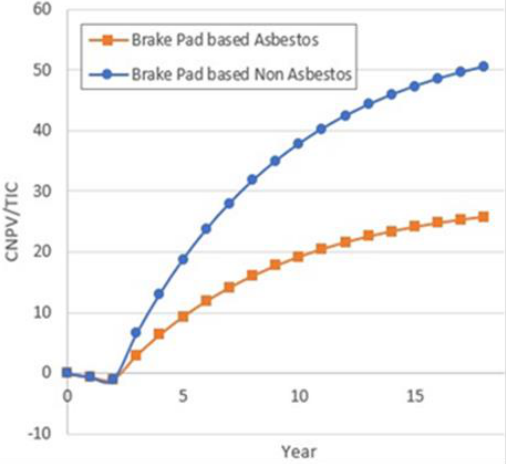
Fig 8.The CNPV/TIC curve against the lifetime for resin-based brake pad project. Figure was adopted from reference